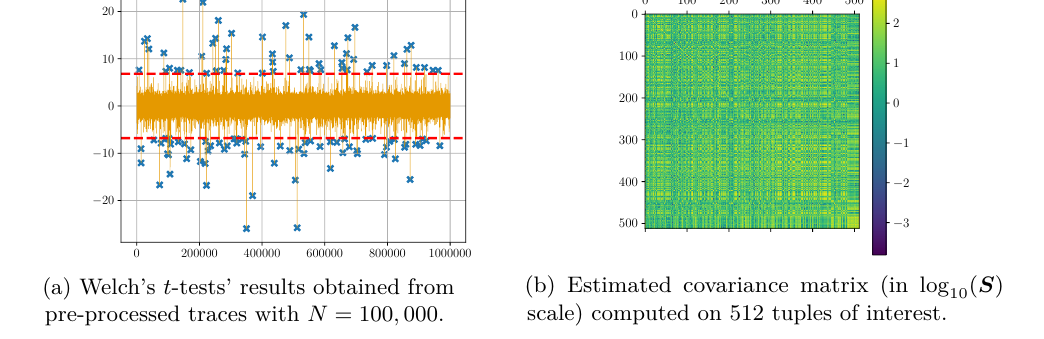
pre-processed traces with N = 100 , 000.